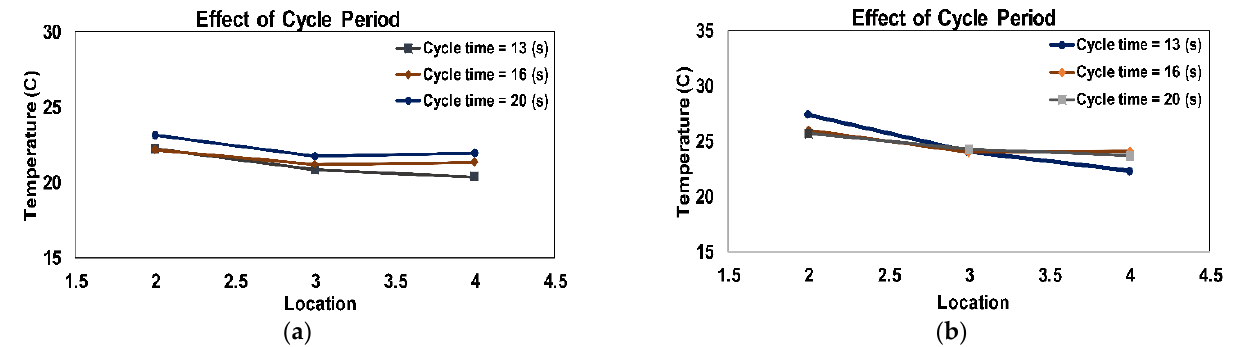
Figure 3. Effect of cycle period on the surface temperature of RMDHL, ( a ) input power 20 W ( b ) input power 60 W.